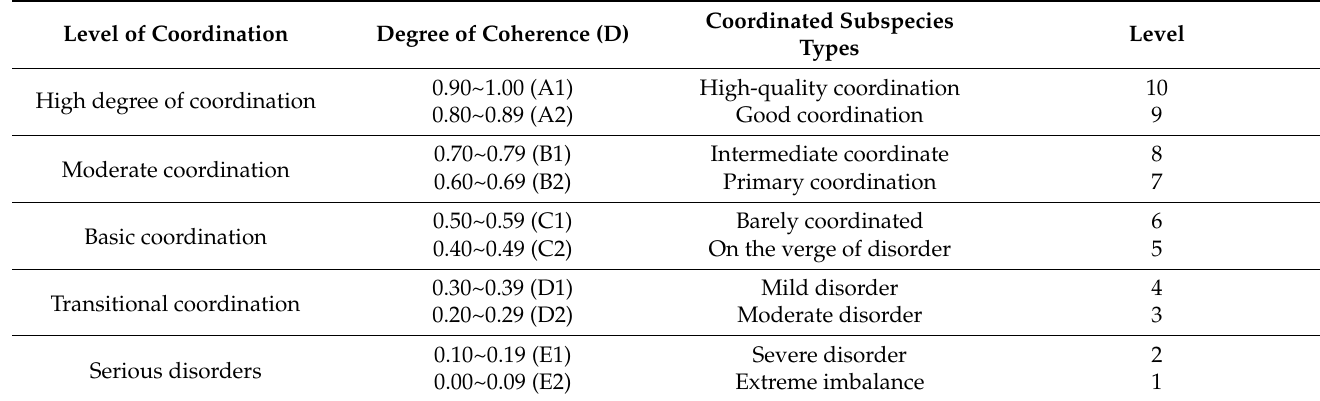
Table 2. Criteria for classifying levels of